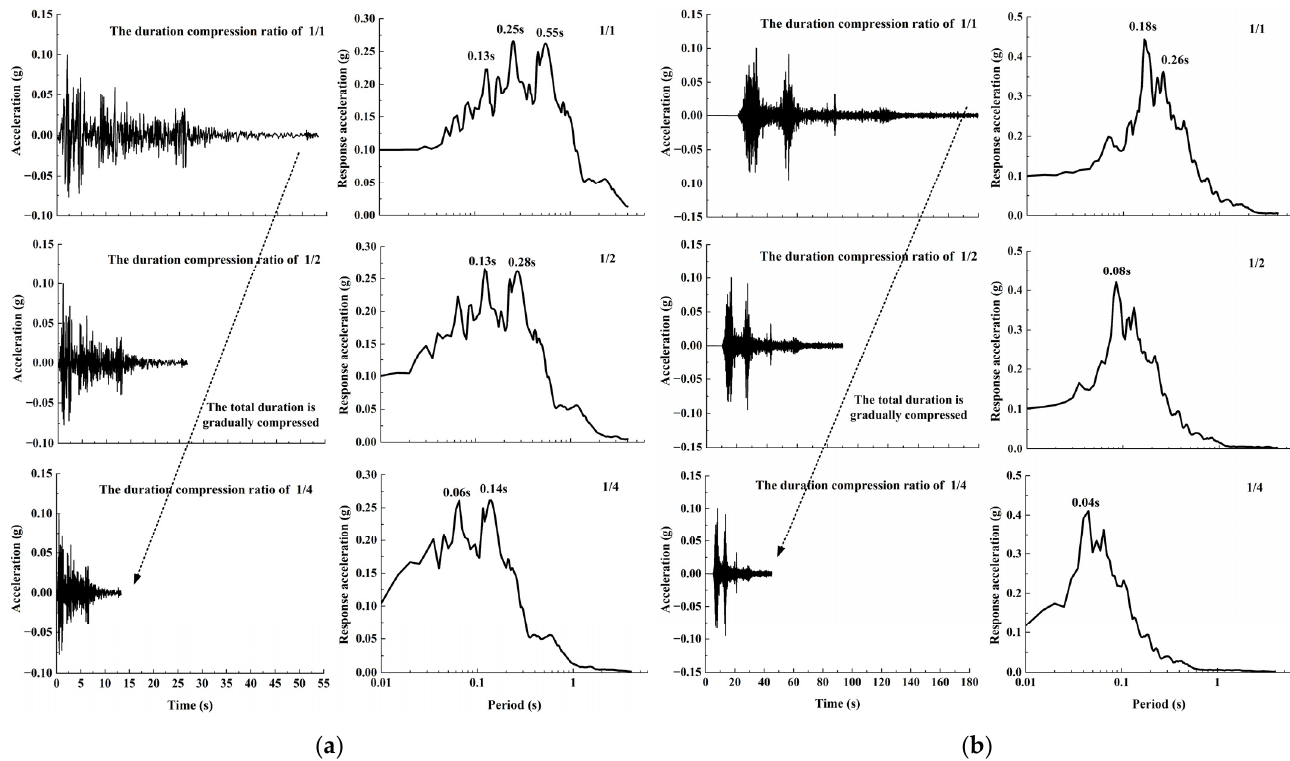
Figure 7. Adopted ground motions: ( a ) El Centro records; ( b ) Wolong records.